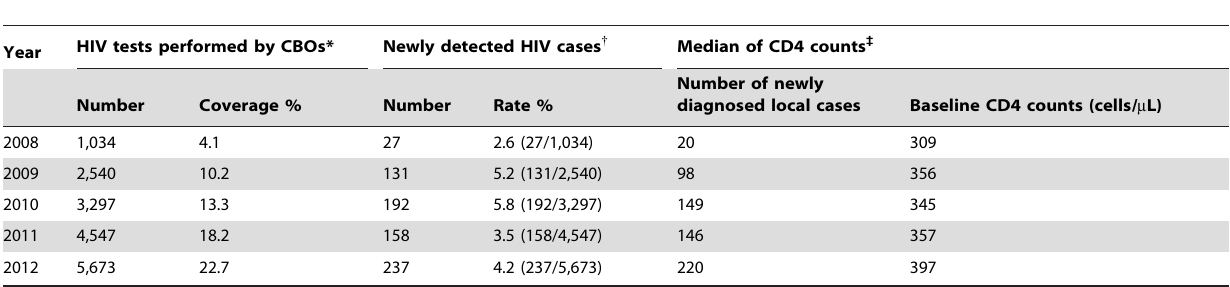
Table 2. The coverage of HIV testing and HIV detection rate among men who have sex with men, the median CD4 counts among local HIV/AIDS cases, through services by community-based organizations (CBOs), 2008 to 2012,Nanjing, China.